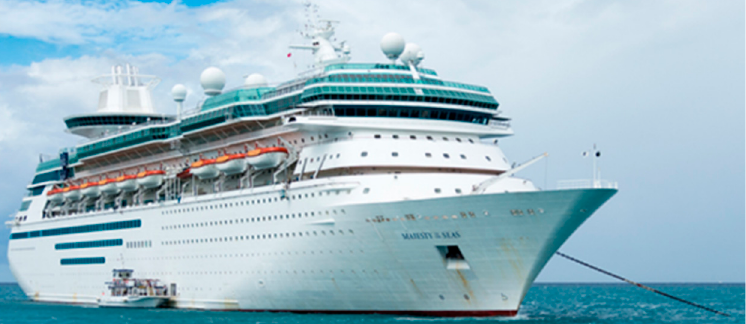
Figure 19. The ferry “MF Hydra” [98].